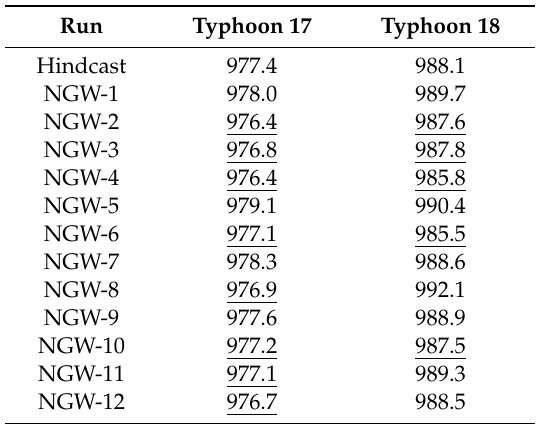
Table 10. Ensemble means of the minimum central pressures of typhoons 17 and